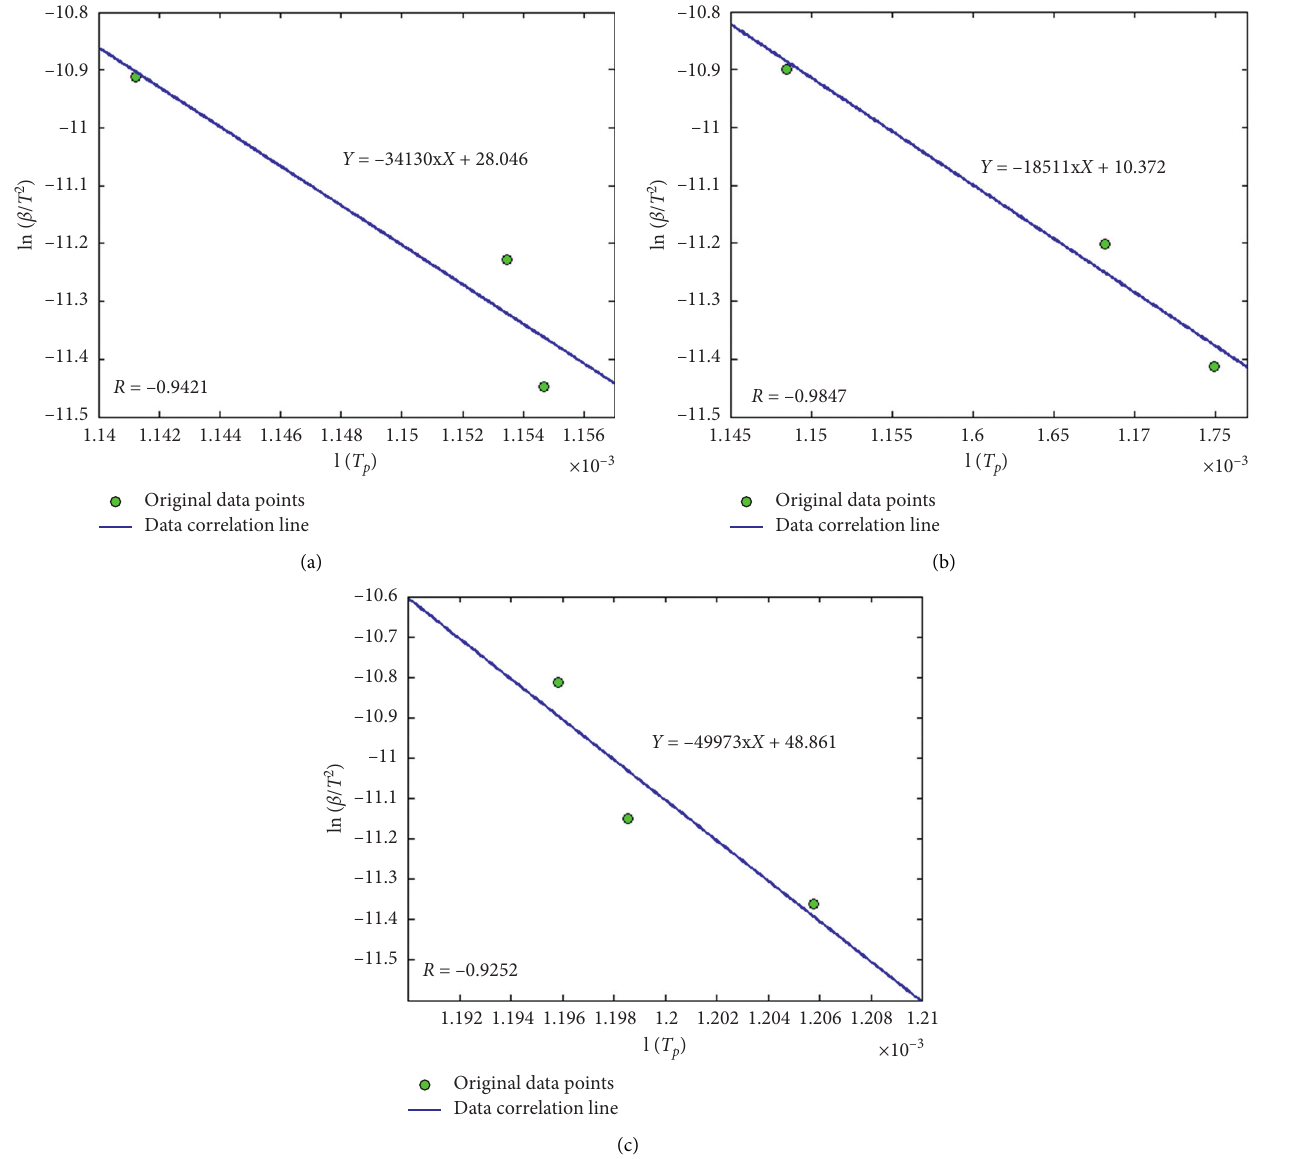
Figure 9: The data correlation line of ln ( β /T2) vs.1/ T nano-Al+micron-MnO 2 thermite. Thermite